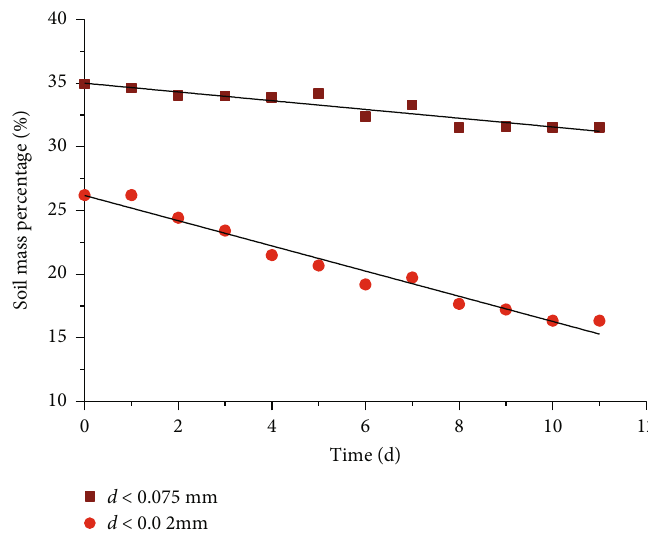
Figure 8: Variations of soil particles with di ff erent sizes during the test.